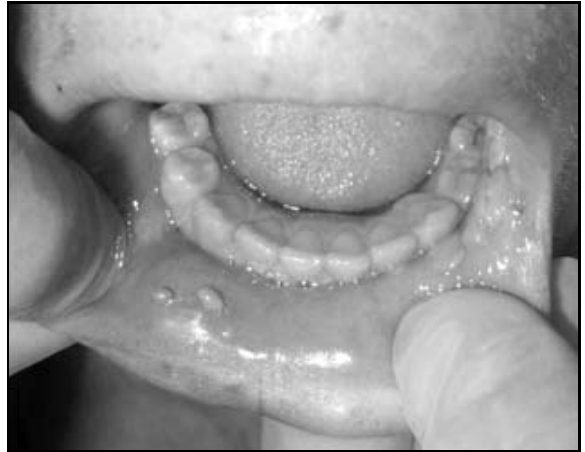
Figura 2 – Nódulos de superfície lisa na mucosa interna do lábio